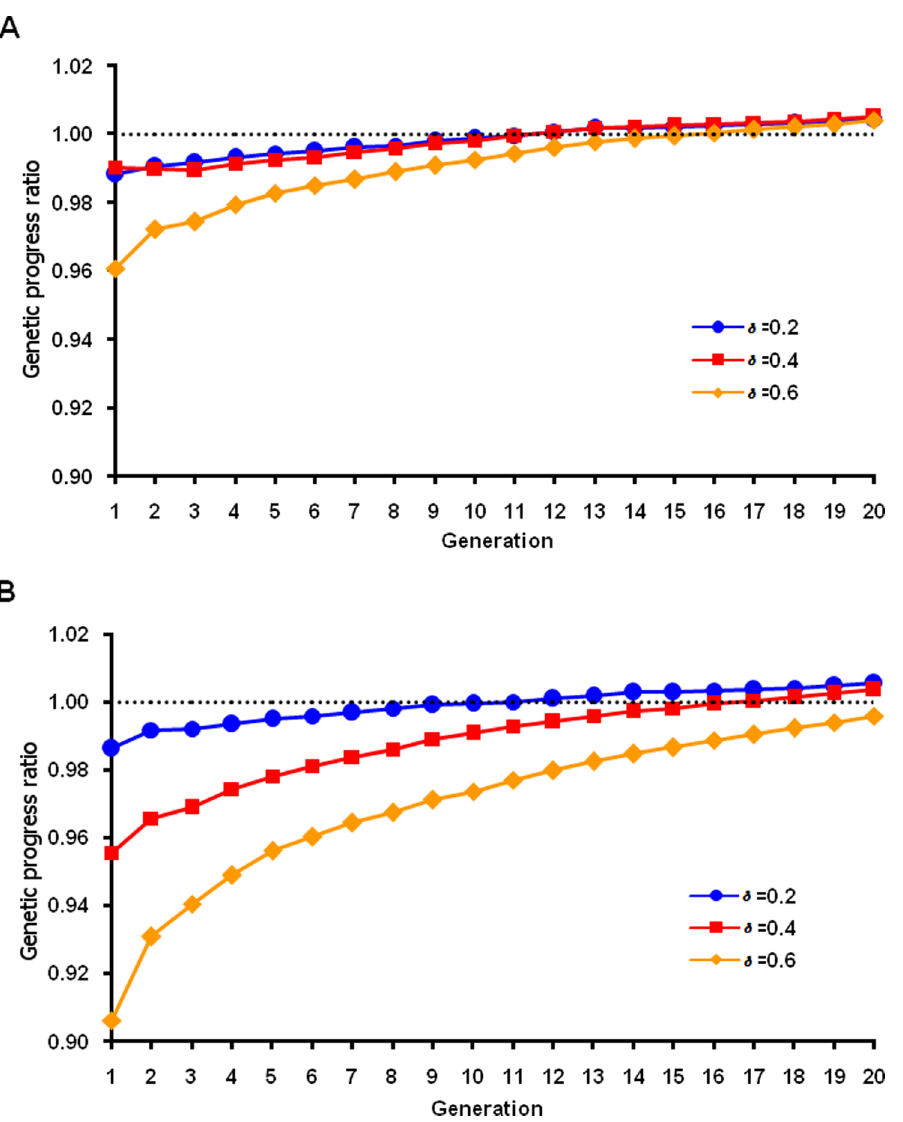
Figure 3. Ratio of adjusted to unadjusted genetic progress by generation for a normal QTL distribution. The ratio was calculated as the genetic progress for a simulated population based on adjusted genomic breeding value using various d in the linear (A) and nonlinear (B) adjustment formula divided by genetic progress based on genomic breeding value from unweighted selection.